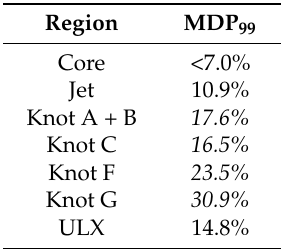
Figure 18. IXPE image of Cen A. The half-power diameter (HPD) is the small circle on the left. An ultra-luminous source of X-rays (ULX) is identified together with the core of Cen A and a number knots. The minimum detectable polarizations based on a 1.5 msec IXPE observation are given in Table 5. Table 5. MDP for different regions of Cen A for 1.5 msec.